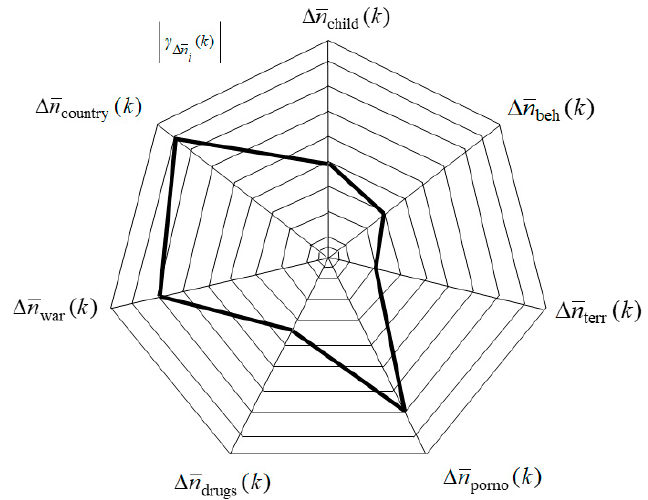
Figure 3. The circular radar chart of the results of experimental calculations of the sensitivity functions values for filtering algorithms for a group of harmful information indicators, which has a negative impact on people.